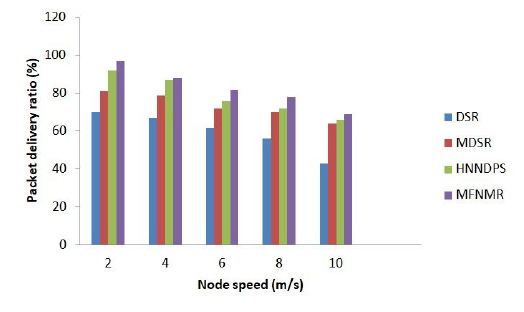
Figure 7. PDR Analysis based on Node